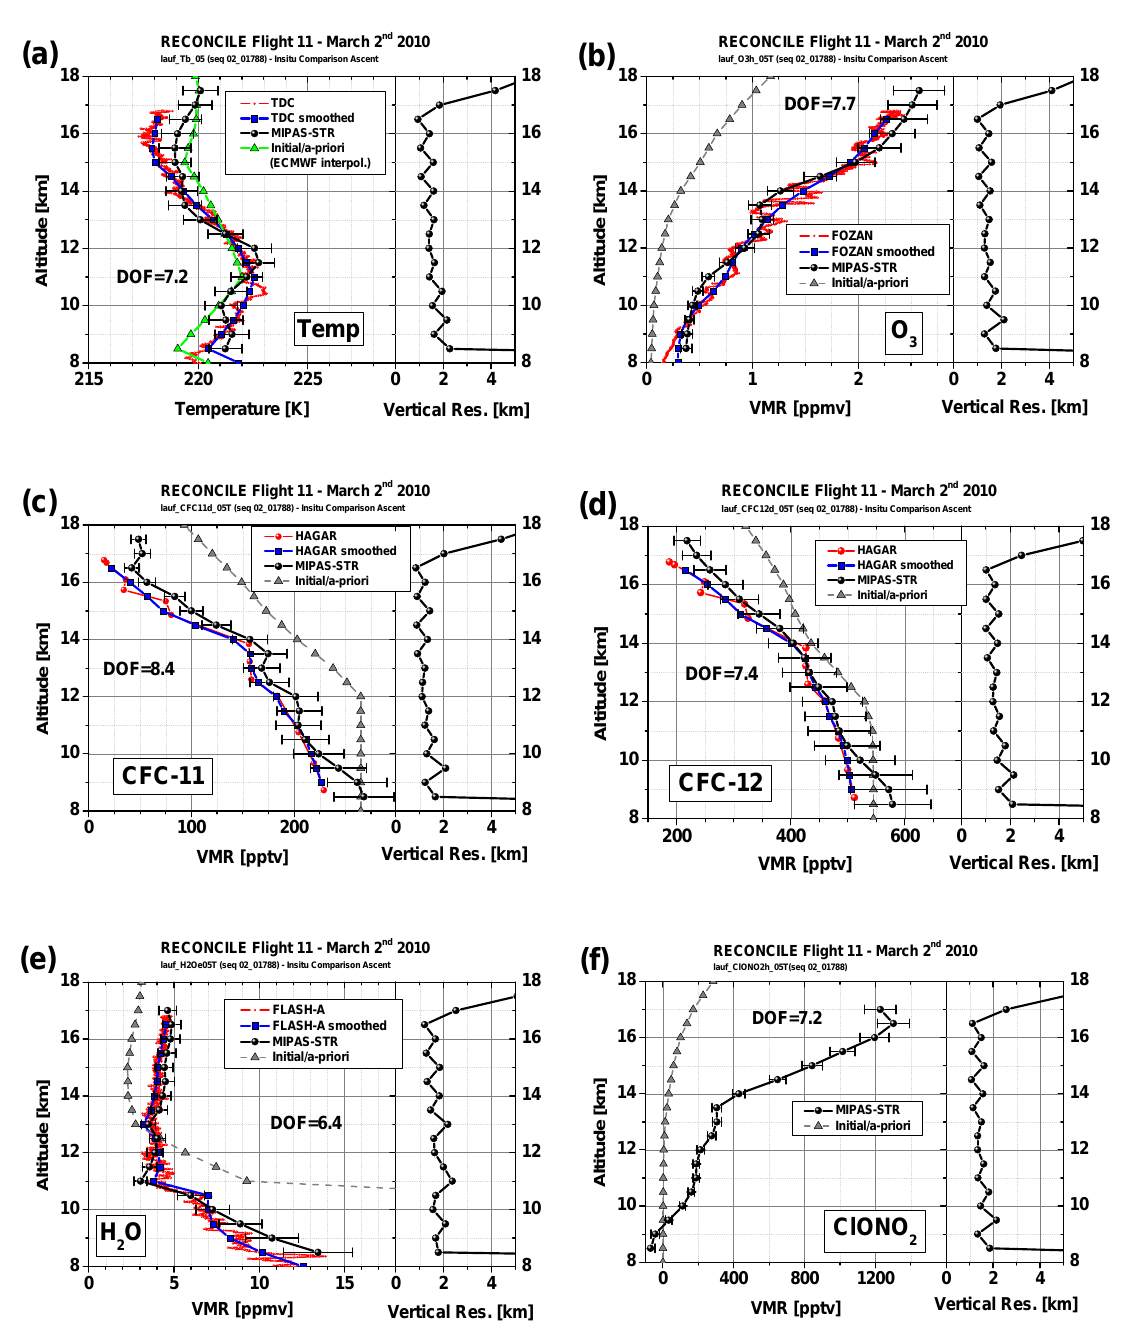
Fig. 15. (a–f) : Retrieved profiles of temperature, O 3 , CFC-11, CFC-12, H 2 O and ClONO 2 with estimated error and comparison with in-situ measurements (left-hand side panels in the plots). Initial guess/a priori profiles for the retrievals and DOF of the results are also indicated. Vertical resolutions of the retrieval results (right-hand side panels in the plots).